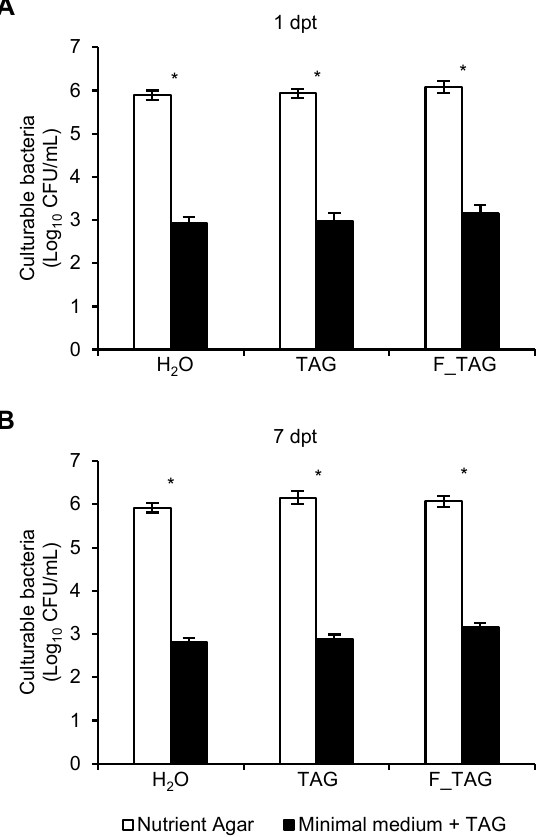
Figure 4. Effects of plant treatments on culturable bacteria of tomato leaves. Bacterial colony-forming units (CFUs) were isolated on nutrient agar (white bars) and a minimal agar medium amended with tagatose, used as the carbon source, (black bars) from leaf washing suspensions collected at one ( A ) and seven ( B ) days post-treatment (dpt) from plants treated with water (H 2 O), 5 g/L pure tagatose (TAG) or a formulated product that contained 5 g/L tagatose (F_TAG). The two-way analysis of variance (two-way ANOVA) showed no significant differences between the two experimental repetitions ( p > 0.05, three replicates per experiment), and data from the two experiments were pooled. Mean and standard error values (Log 10 -transformed) from six replicates (each as a pool of 50 leaves collected from 20 plants) from the two experiments are presented for each treatment. For each treatment, significant differences between bacterial CFUs on nutrient agar and a minimal agar medium amended with tagatose are marked with an asterisk (*), according to the Student’s t -test ( p ≤ 0.05). No differences were found among treatments at 1 dpt and 7 dpt, according to Tukey’s test ( p > 0.05).